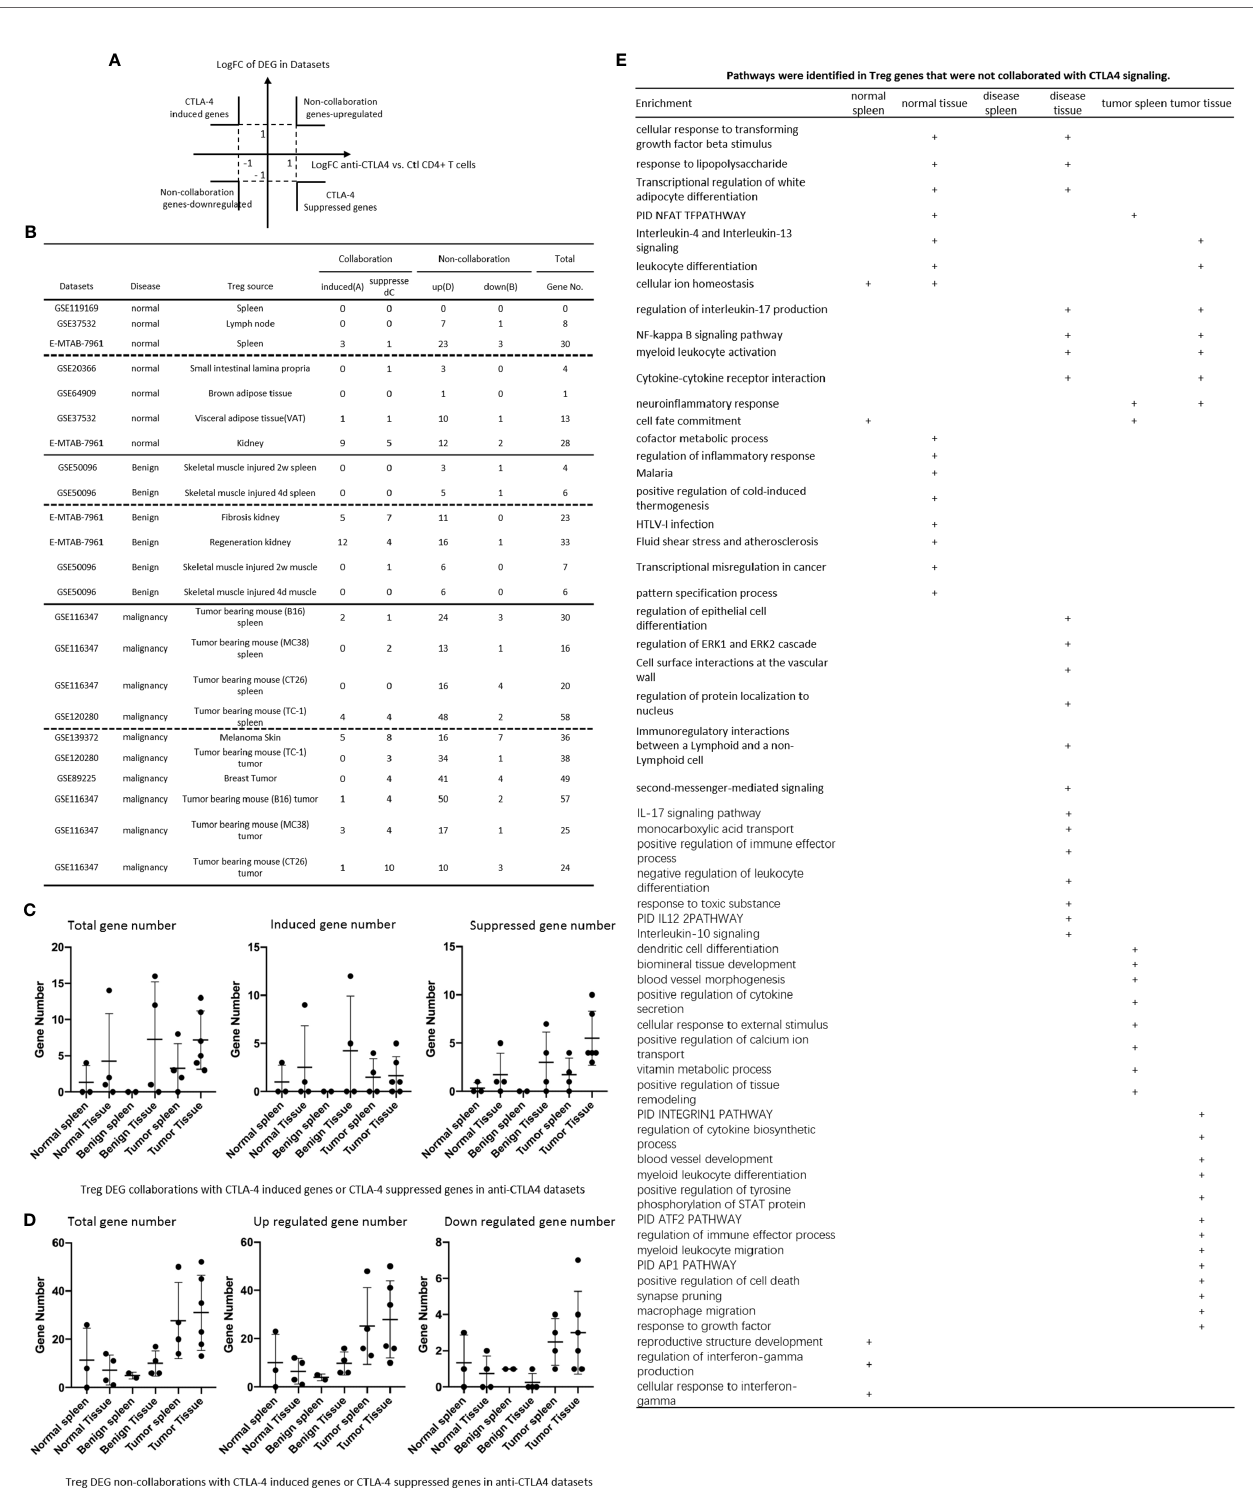
FIGURE 7 | (A, B) All the upregulated genes and downregulated genes in tissue Treg groups were compared to anti-cytotoxic T cell antigen-4 (CTLA-4) antibody- treated Treg (CTLA-4 signaling suppressed) versus CTLA-4 signaling non-suppressed CONTROL CD4+ T cell dataset (GSE14716) to determine how many Treg genes were dependent on CTLA-4 signaling. (C) Treg DEG collaboration with CTLA-4 induced genes and CTLA-4 suppressed genes in anti-CTLA-4 datasets. (D) Treg DEG non-collaboration with CTLA-4 induced genes and CTLA-4 suppressed genes in anti-CTLA-4 datasets. (E) pathways identi fi ed in Treg genes and not collaborated with CTLA-4